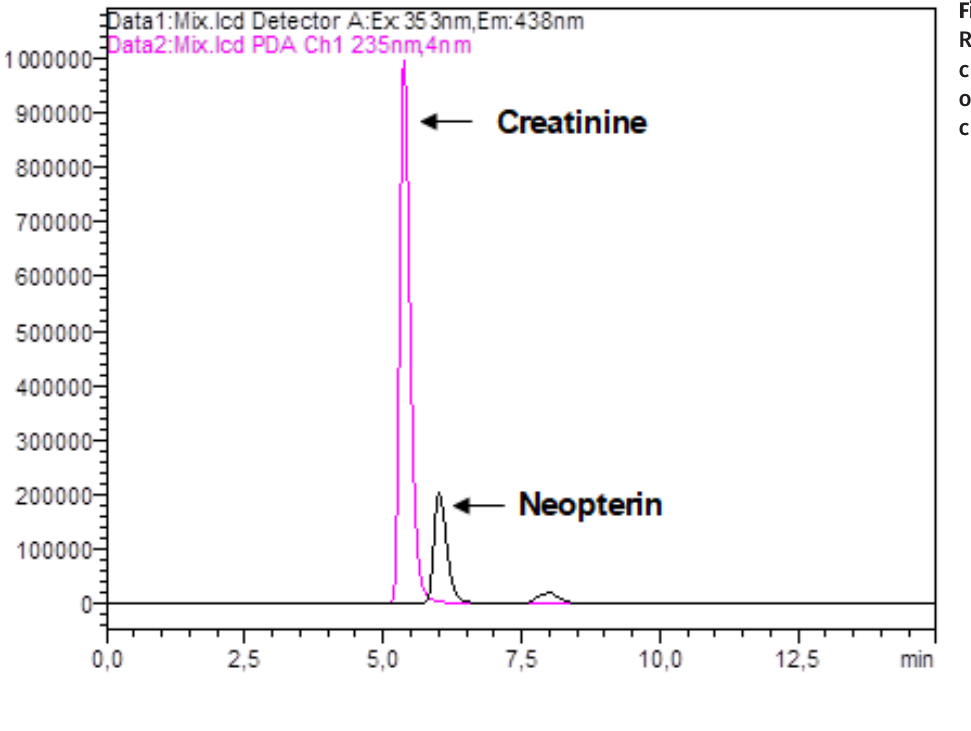
Figure 2. Representative chromatograms of neopterin and